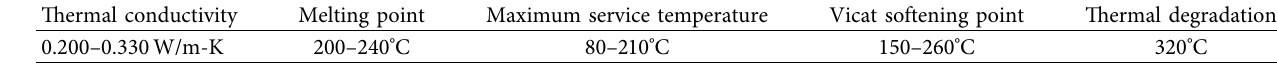
Table 4: Termal properties of the PJ-reinforced nylon FRP